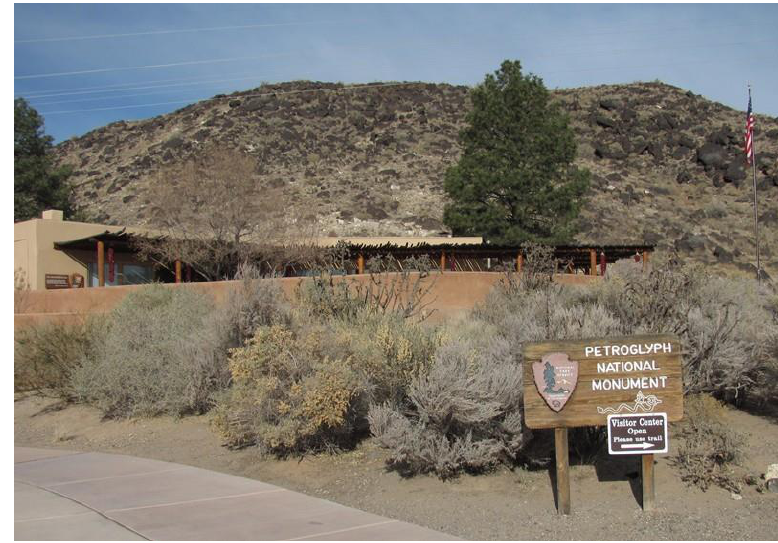
Figure 14. Petroglyph National Monument, New Mexico [52]